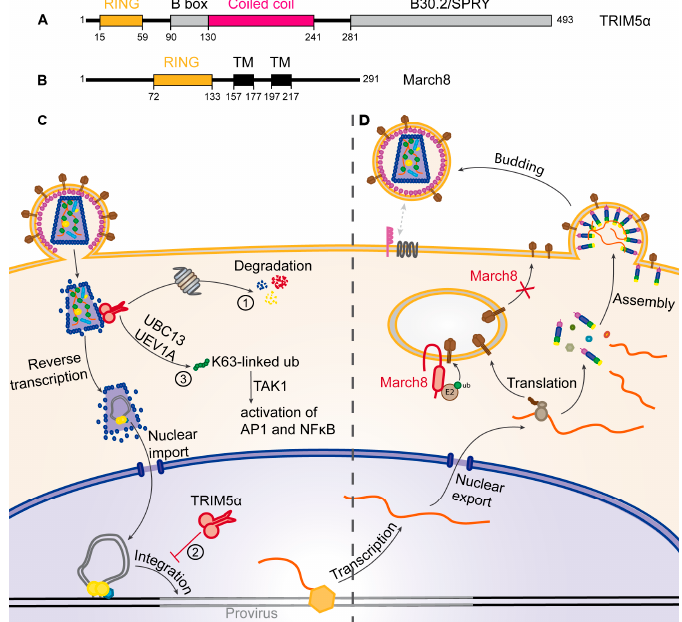
Figure 3. Restriction of HIV by TRIM5 α and March8. ( A , B ) Schematic representation of the main domains of ( A ) the TRIM5 α and ( B ) March8 proteins. Black boxes correspond to transmembrane domains (TM). Amino acid positions of the beginning and end of the domains as well as the total length of the proteins are indicated; ( C ) mechanism of TRIM5 α restriction. The dimeric TRIM5 α (red) recognizes the viral capsid and ① induces the proteasomal degradation of the capsid (blue), the integrase (yellow) and itself, leading to premature decapsidation of viral RNA. ② TRIM5 α also blocks integration of the provirus (red T bar) and ③ induces activation of AP1 and NF κ B pathways; ( D ) March8 (red) mediates intracellular retention of envelope proteins (Env, brown), leading to reduced Env incorporation into virions, thereby decreasing infectivity.